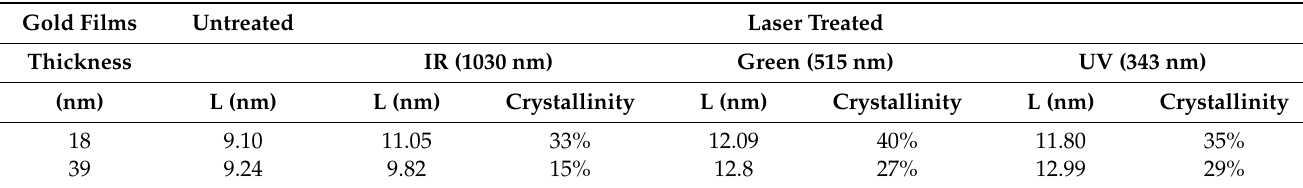
Table 2. Estimated crystallite size from XRD analysis and corresponding improvements in crystallinity for IR, green and UV linity for IR, green and UV laser, respectively. laser, respectively. Gold